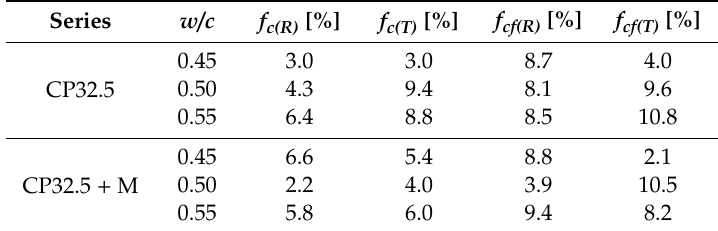
Table 2. Values of coe ffi cients of variation for the results of mechanical parameters.